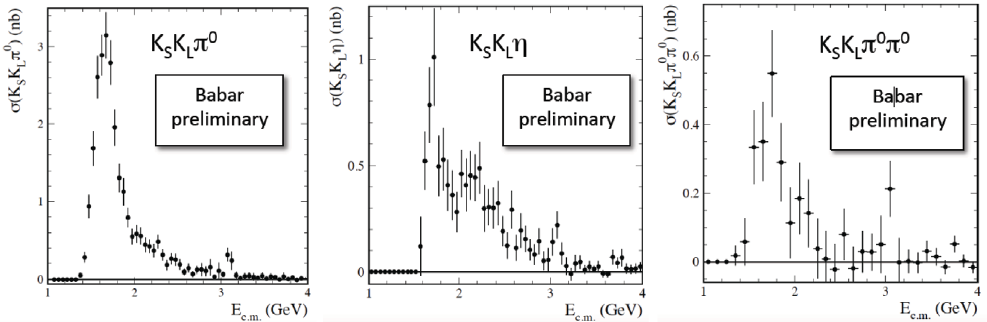
Figure 5. Babar measurements of the (left) e + e − → K S K L π 0 , (center) K S K L η , and (right) K S K L π 0 π 0 cross